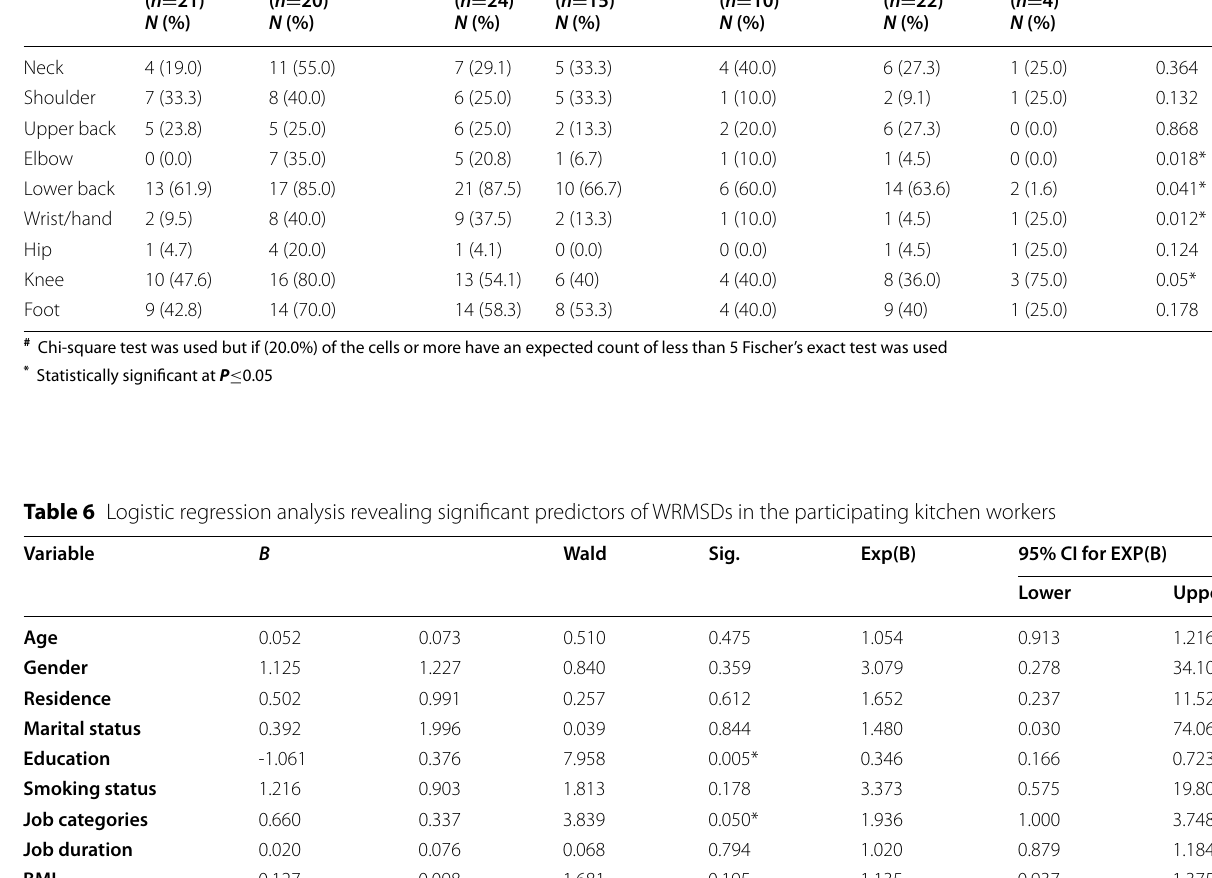
Table 5 Musculoskeletal problems in various joints in different job categories (as per Standardized Nordic Questionnaire)